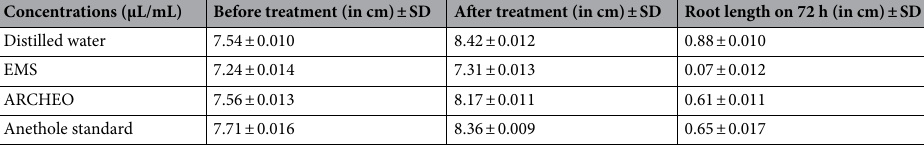
Table 6. Root lengths of Allium cepa after treatment of ARCHEO , anethole (standard) and EMS. ARCHEO anethole rich C. heptaphylla essential oil, EMS Ethyl methanesulphonate.